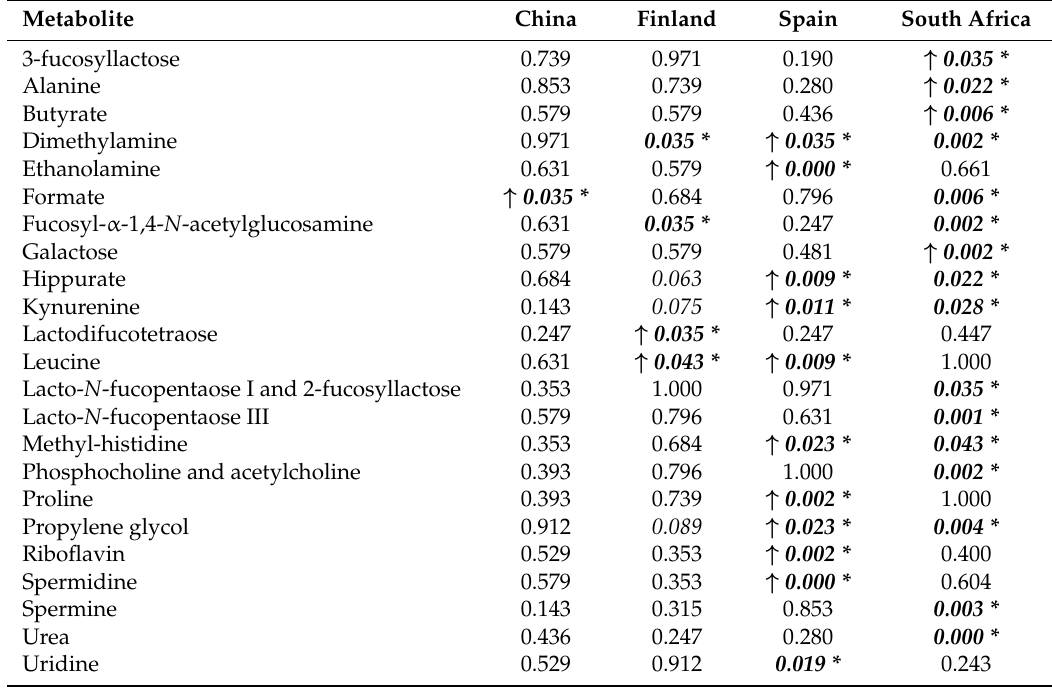
* indicate p -values < 0.05. ↑ indicate significant higher levels in milk from caesarean section donors.